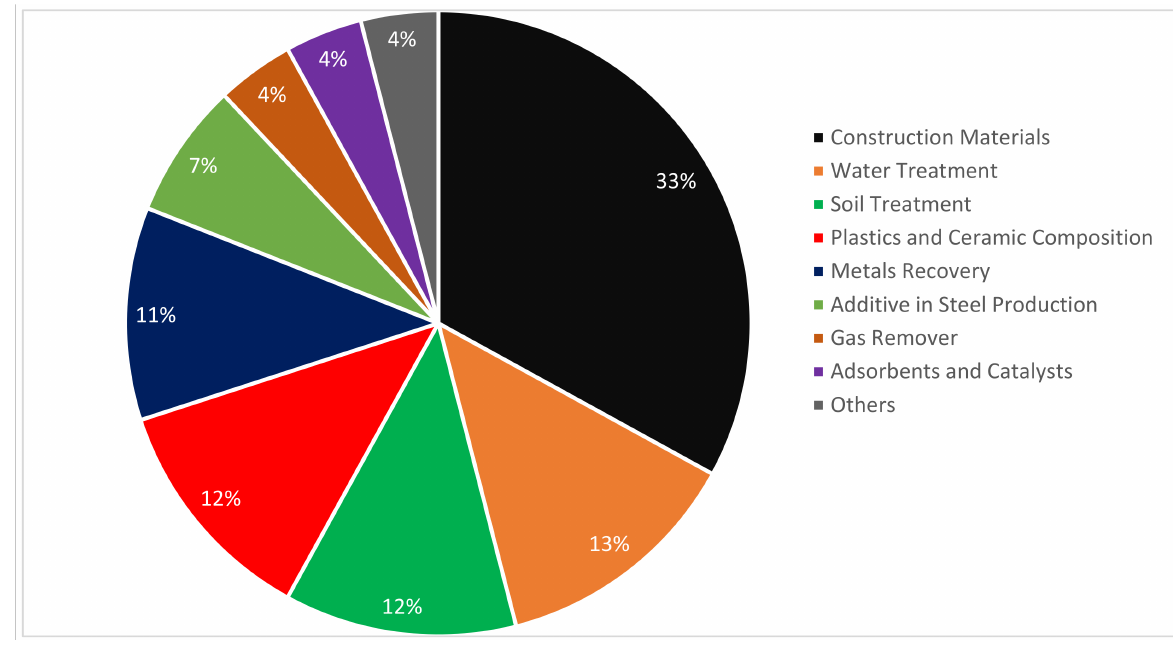
Figure 3. RMD Application (1964 to 2008): Data source